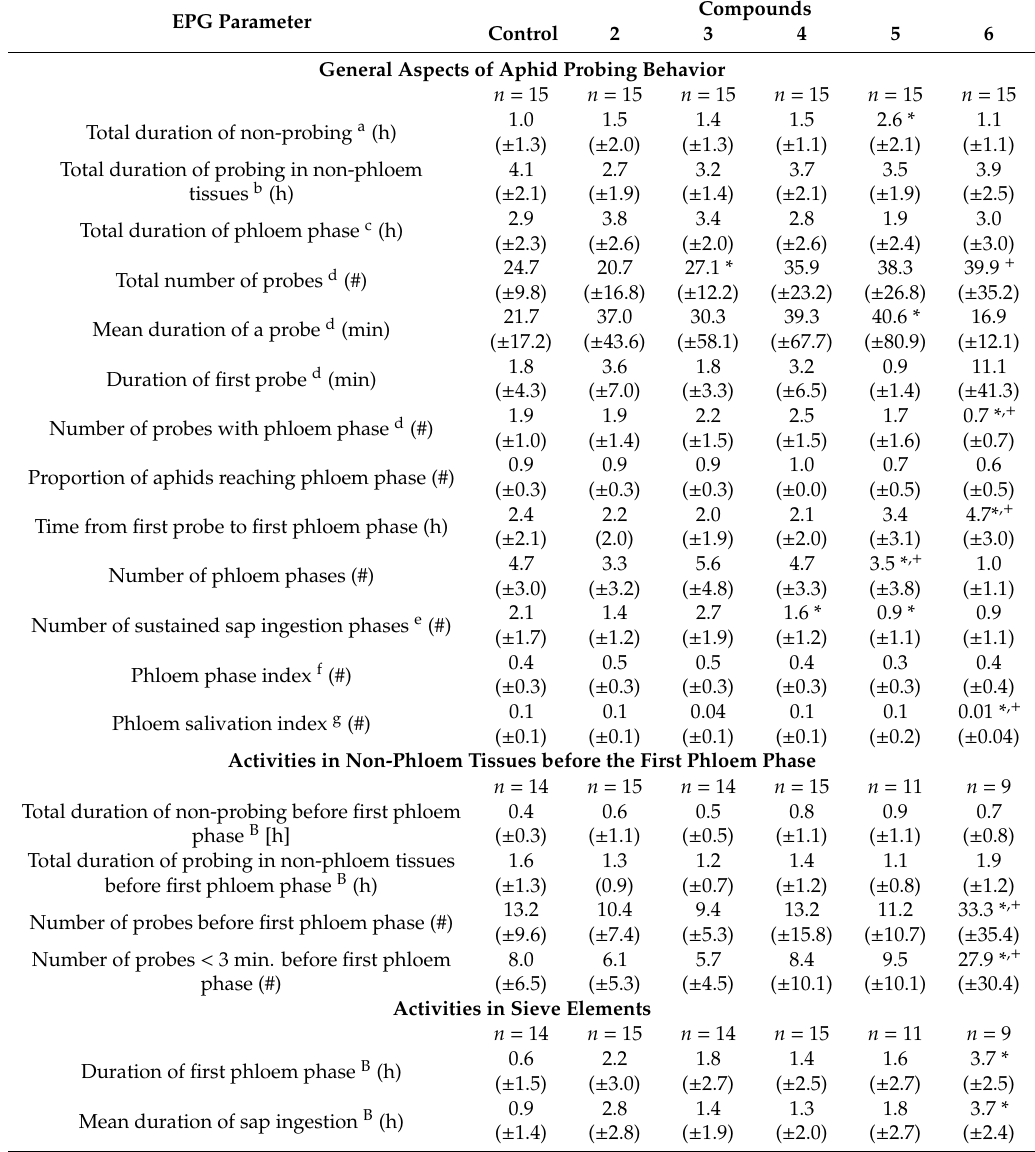
Table 2. Probing behavior (EPG parameters) of Myzus persicae on Brassica rapa subsp. pekinensis leaves treated with ( + )- β -thujone ( 2 ) and its derivatives: bisulfite adduct ( 3 ), lactone ( 4 ), oxime ( 5 ), lactam ( 6 ) A . The same plant was used to maintain the aphid stock